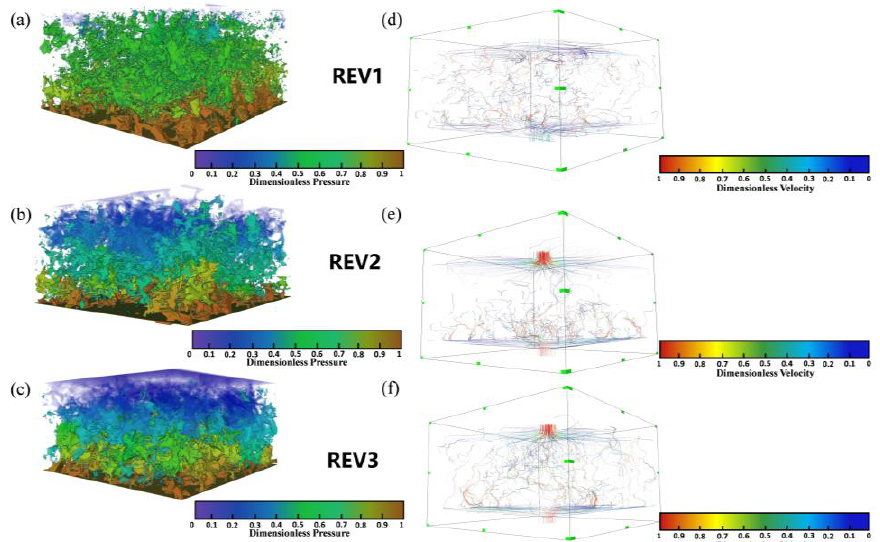
Figure 11. Pressure ( a – c ) and velocity ( d – f ) distributions of REV1, REV2 and REV3, two parameters are presented in the dimensionless form ranging from 0 to 1, aiming to illustrate the big contrast.